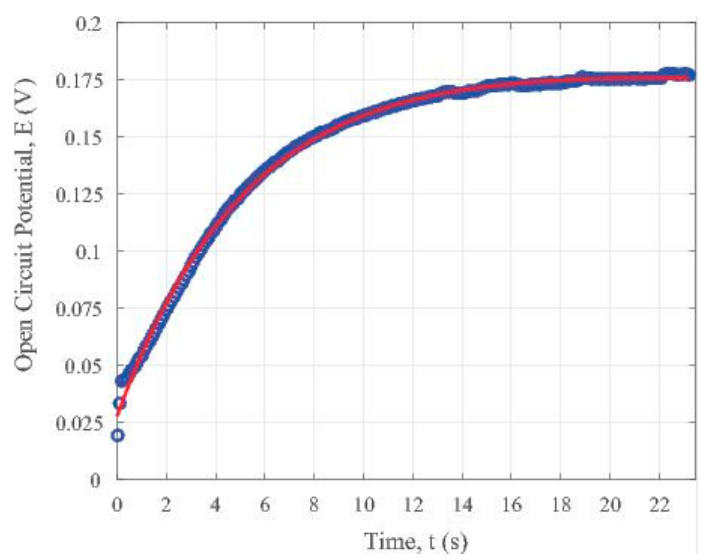
Figure 6. Recovery of the iron oxide nanoparticles loaded carbon fiber specimen after the shut off of the visible light illumination.